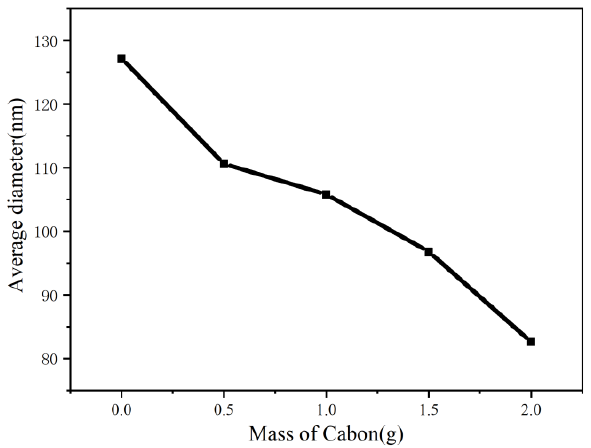
Figure 8. The changing trend of nanofiber’s diameter.